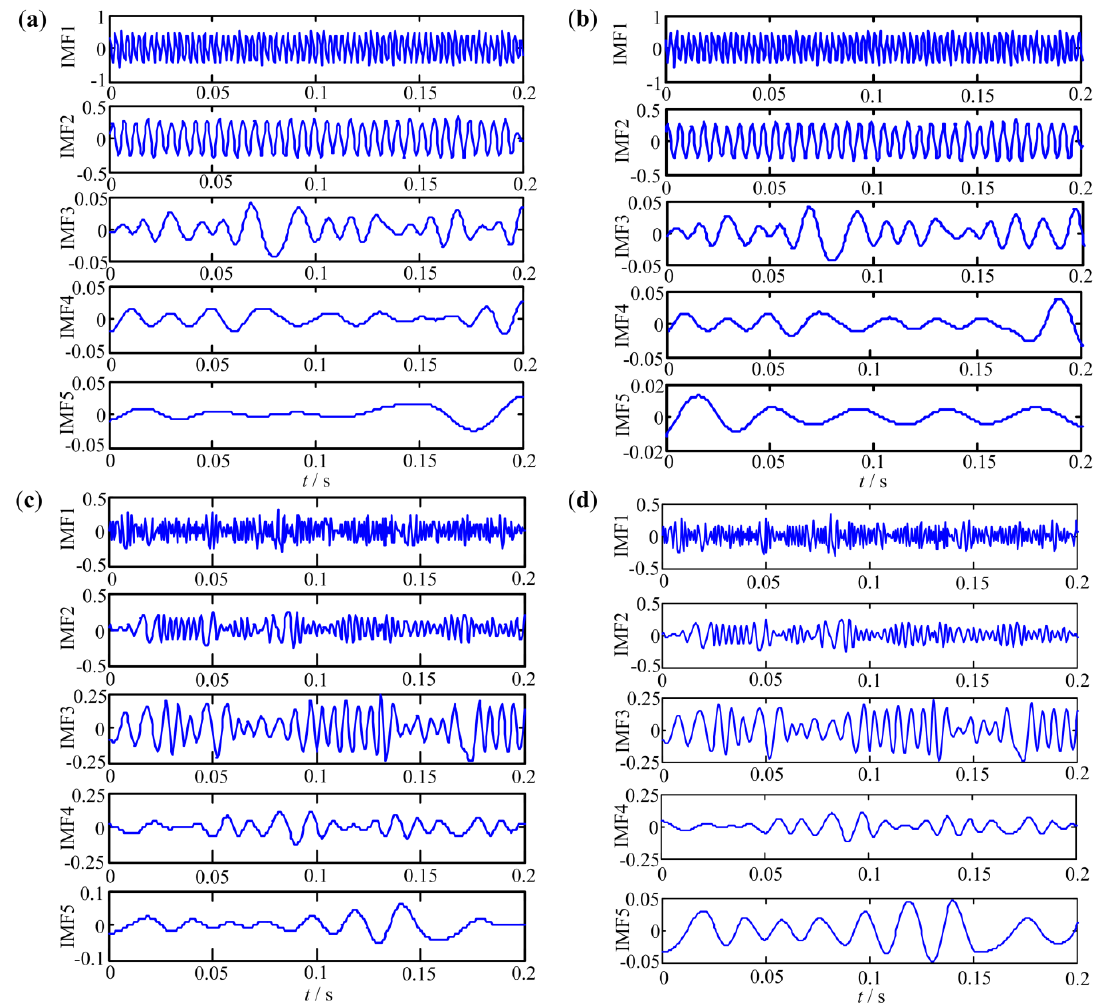
Figure 7. The decomposition results for the normal pressure signals using ( a ) EMD2, ( b ) EMD3, and the results for the slight degradation pressure signals using ( c ) EMD2, ( d ) EMD3.